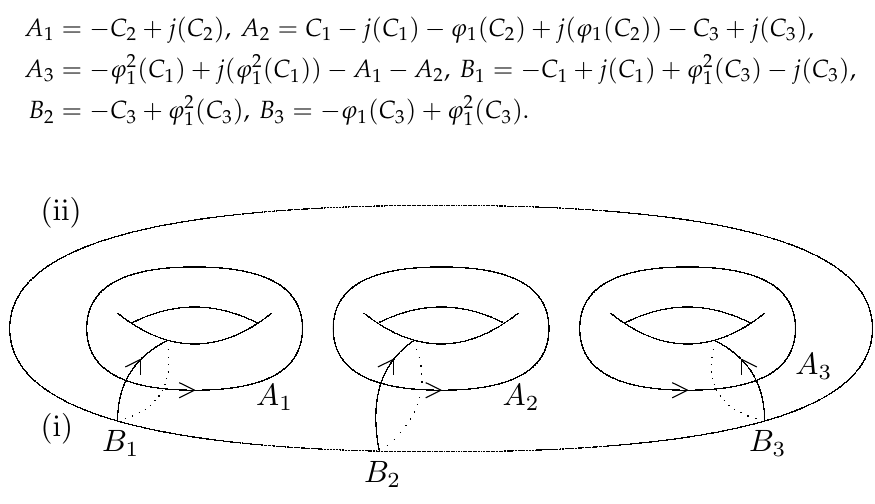
Figure A13. A canonical homology basis on M